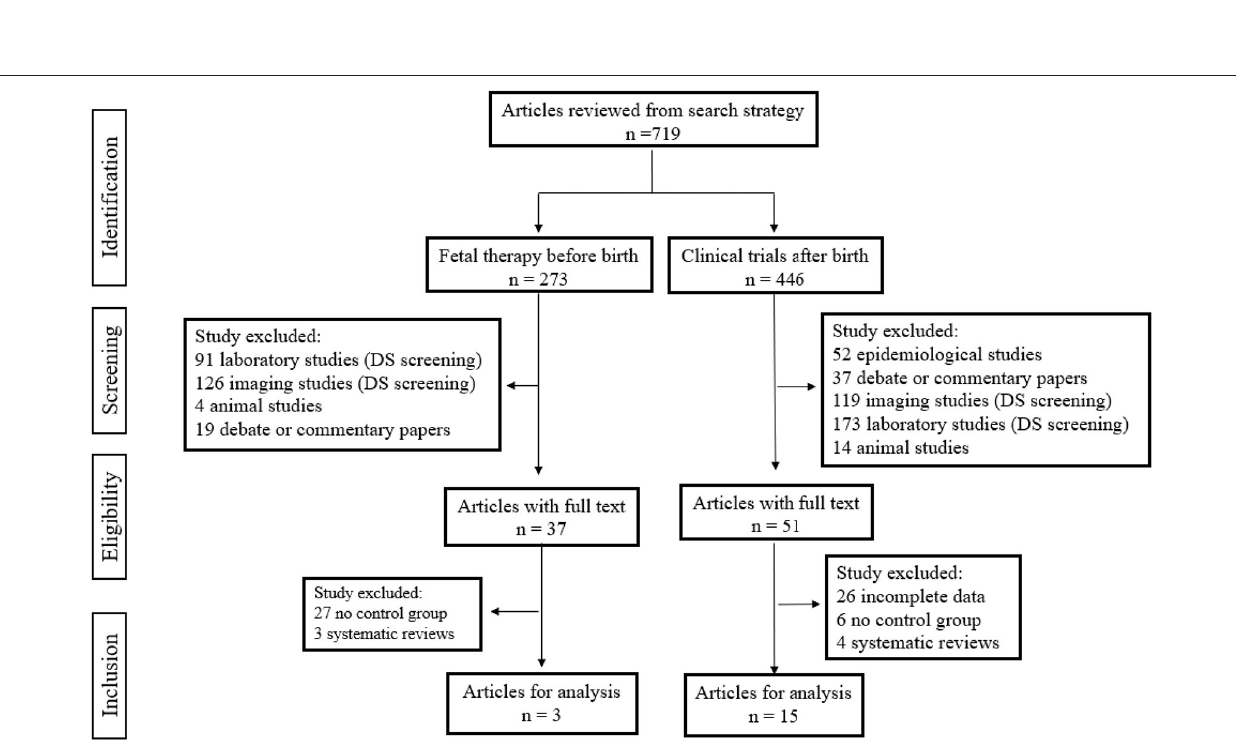
Frontiers in Medicine | www.frontiersin.org 4 July 2022 | Volume 9 | Article